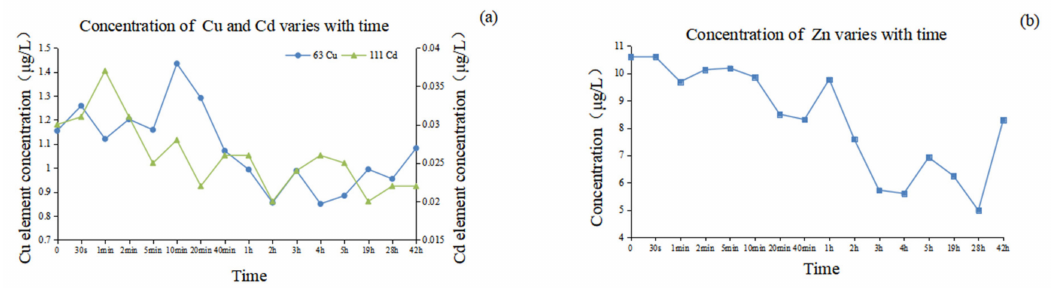
Figure 7. In UF water the effects of suspended particulate matter at different time adsorption and release of Cu and Cd ( a ); Zn ( b ).